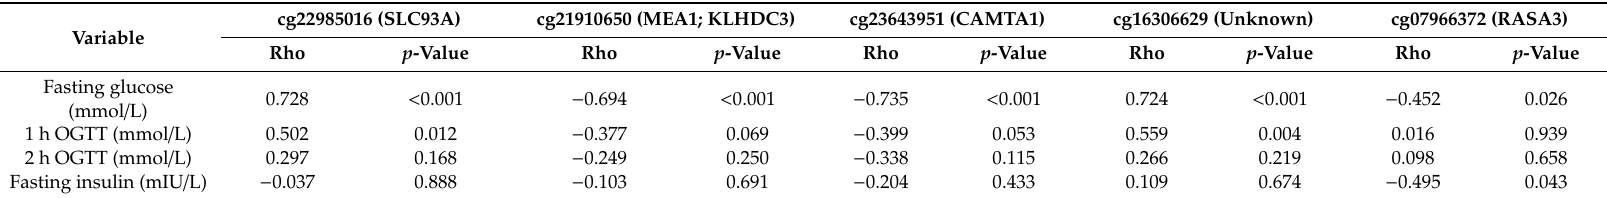
Table 4. Correlation analysis showing the association between DNA methylation and fasting plasma, 1 h OGTT, 2 h OGTT and fasting insulin for the top five di ff erentially methylated CpG